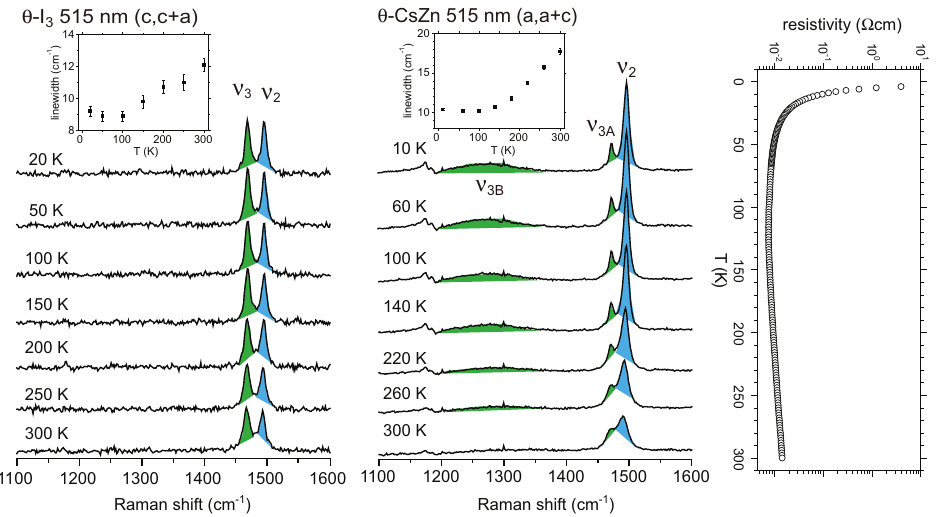
Figure 16. Temperature dependence of the Raman spectra of θ -(BEDT-TTF) CsZn(SCN) along with the electrical resistivity of θ -(BEDT-TTF) θ -(BEDT-TTF) 2 4 . The inset shows the temperature dependence of the linewidth of the ν CsZn(SCN) 4 I and θ -(BEDT-TTF) The Raman spectra of θ -(BEDT-TTF) 2 3 from Figure 2c of ref. [111] and Figure 3 of ref. [94], respectively.